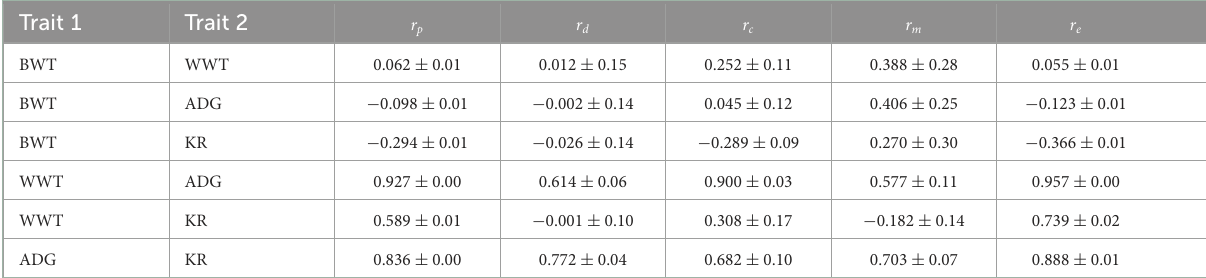
TABLE 6 Estimates of the (co)variance components and the genetic parameters for each trait using the best models by bivariate analysis. Trait 1 Trait